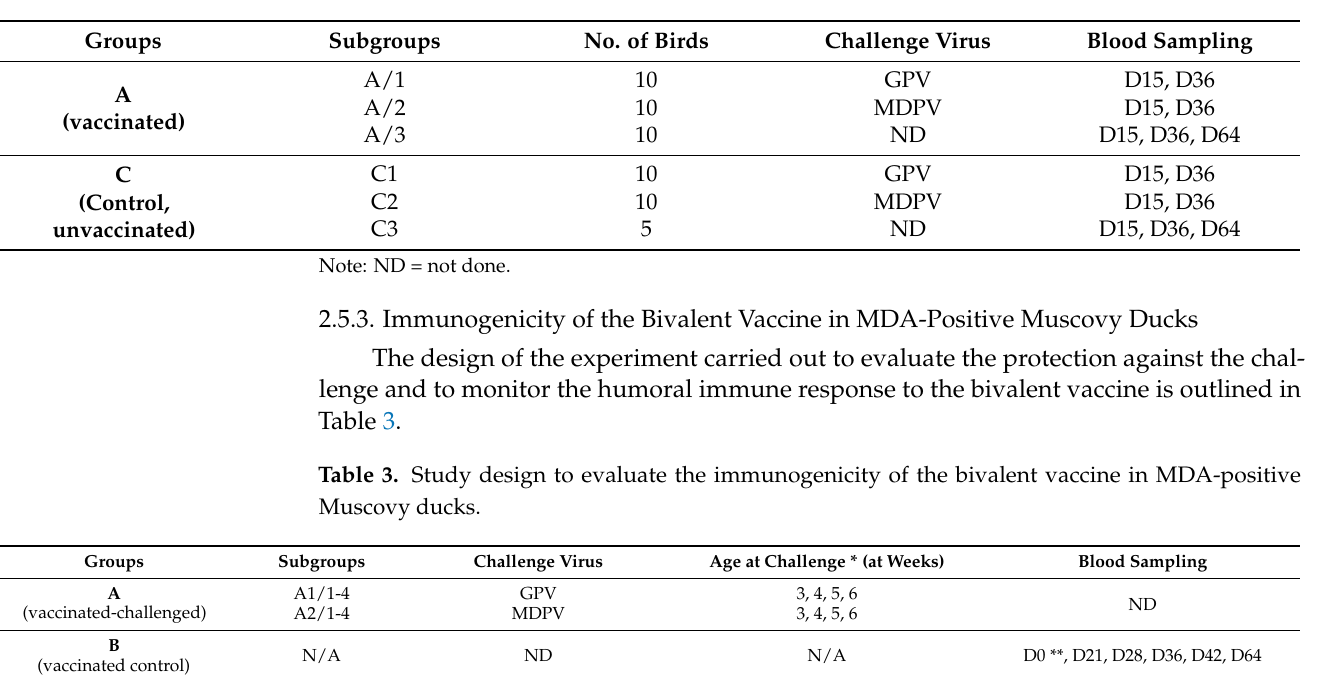
Table 2. Study design to evaluate the immunogenicity of bivalent vaccine in MDA-free Muscovy ducks.